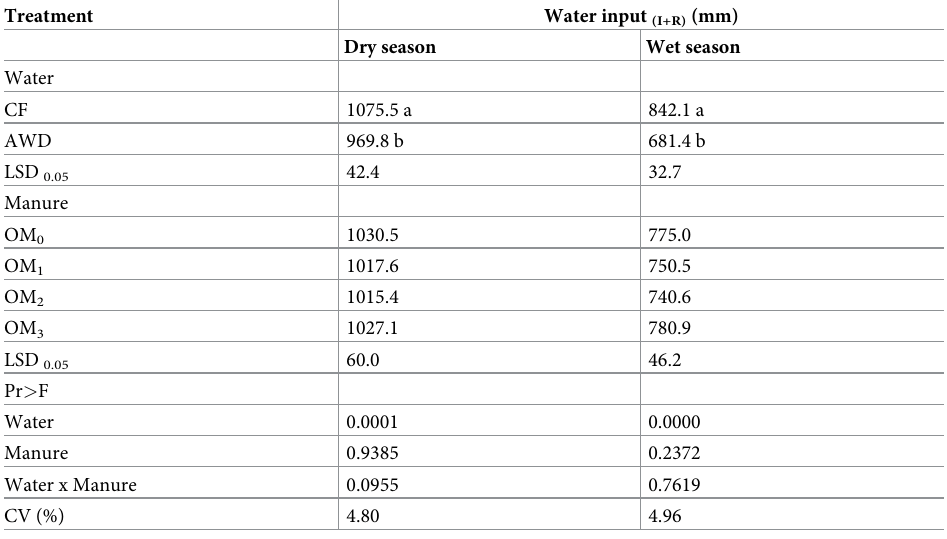
Within each column, values with different alphabets indicate significant differences among the treatments at 5% of LSD test.